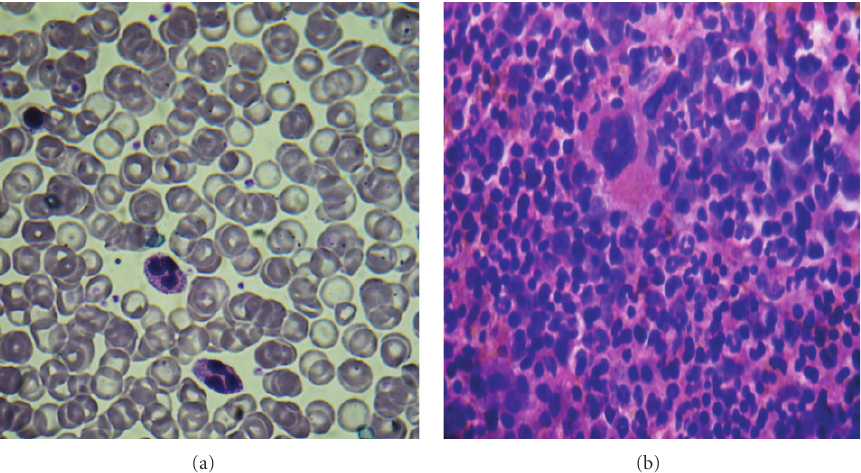
Figure 3: (a) blood smear displaying hypochromic red cells and increased neutrophils. A nucleated red cell is also seen. (b) Hypercellular marrow with obliteration of fat spaces. H&E